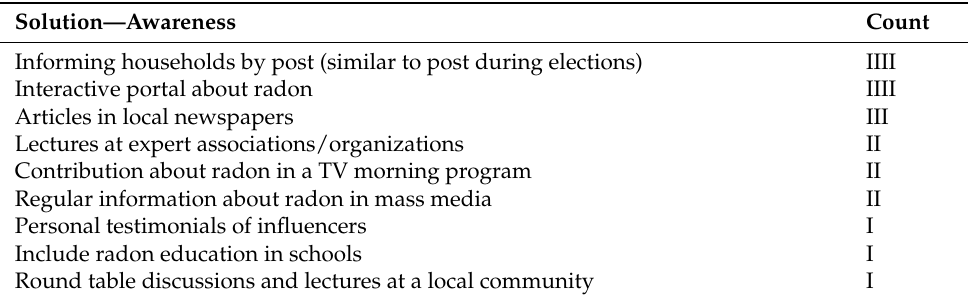
Table 4. Slovenia: solution statements awareness—converging.